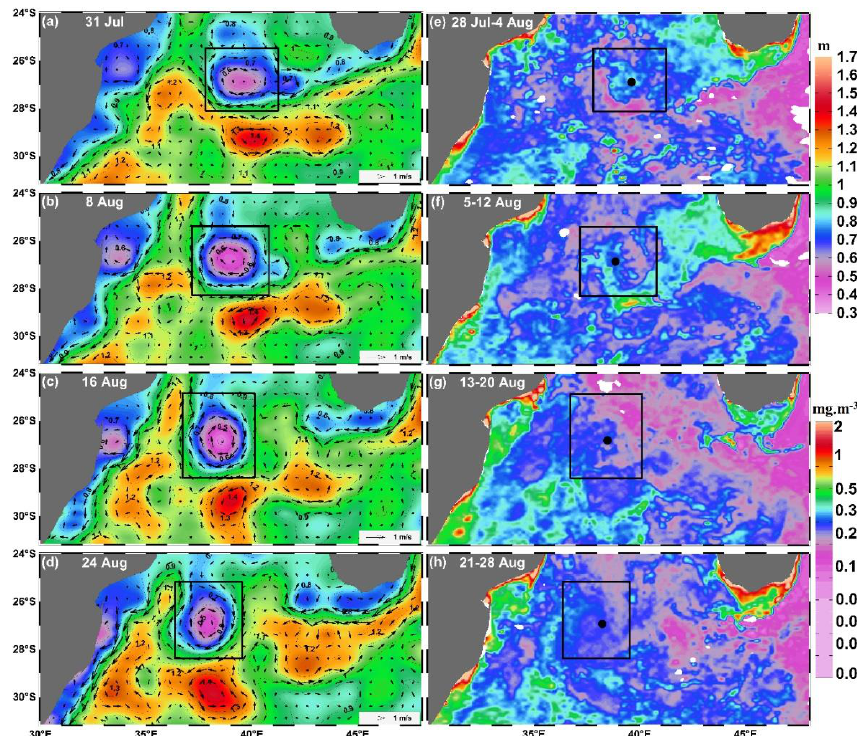
Figure 5. Fractional contribution of ( a – d ) micro-, ( e – h ) nano-, and ( i – l ) picophytoplankton to MODIS Aqua chlorophyll a for 18 June to 27 July 2013 over the Mozambique Basin. Black boxes highlight the location of the cyclonic eddy and black dots indicate the centre of the eddy. White areas indicate missing data due to cloud cover.